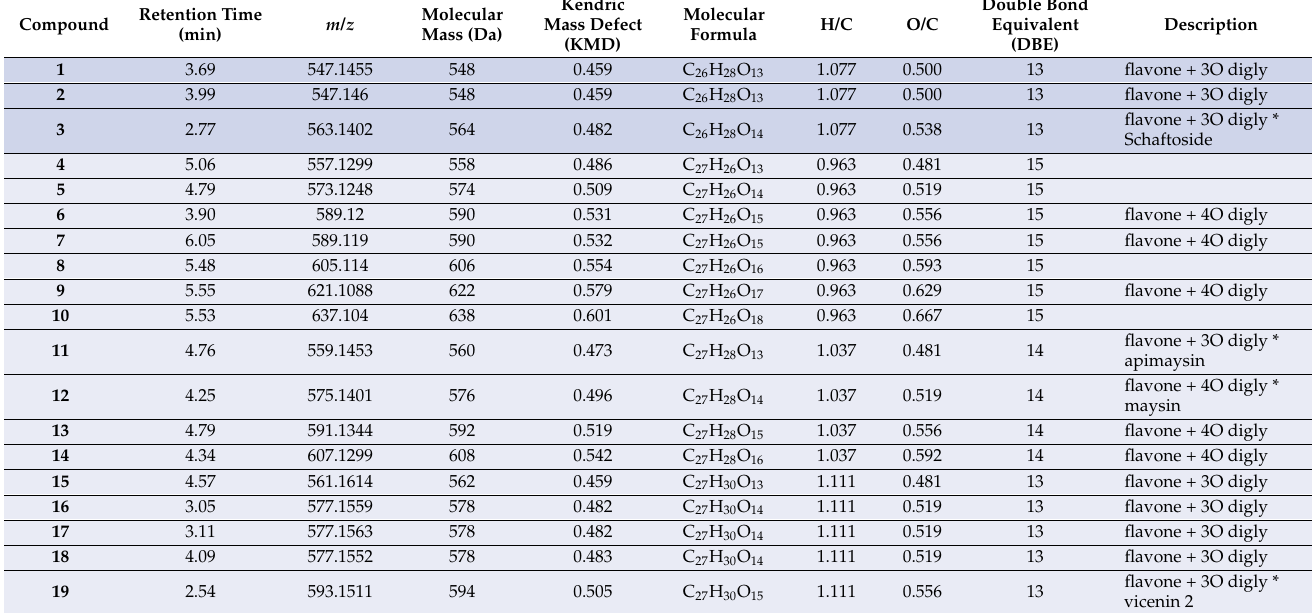
Table 3. Characteristics of phenolic compounds. The background colors indicate the different homologous carbon